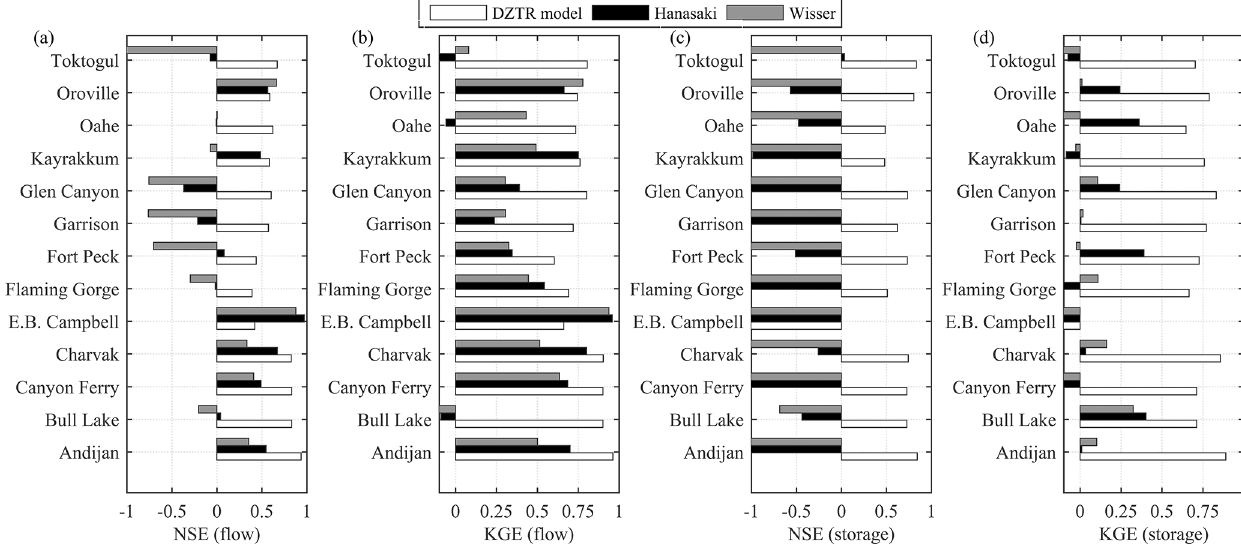
Figure 8. A comparison of our proposed reservoir operation model with generalized parameters with the models of Hanasaki et al. (2006) and Wisser et al. (2010): (a) NSE (flow), (b) KGE (flow), (c) NSE (storage), and (d) KGE